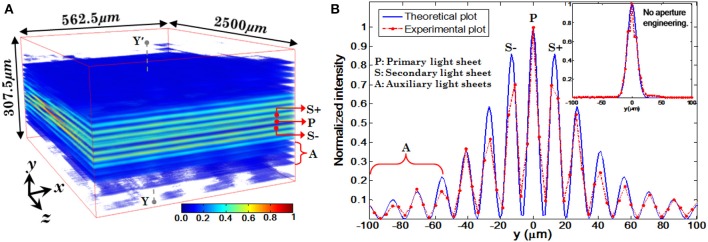
(A) Volumetric rendition of the experimentally obtained PSF (spatial filter parameters: λexe = 532 nm, α = 1.17°, β = 0.99°, θp = 0°). (B) Intensity plots of experimentally obtained illumination PSF and its comparison with simulated PSF (Purnapatra et al., 2014).